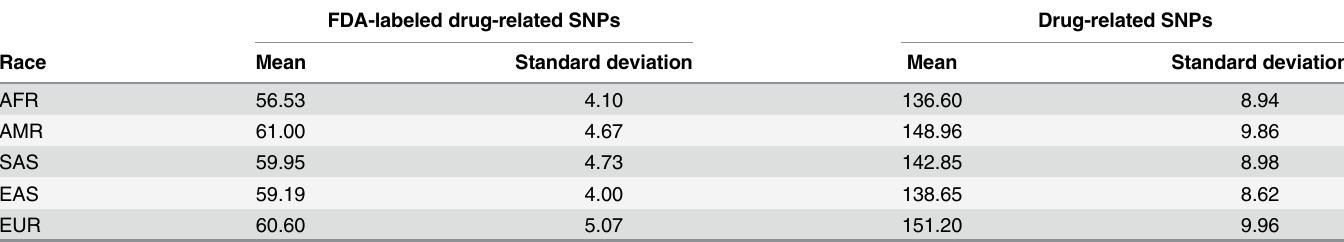
Table 2. Summary of drug-related SNPs among